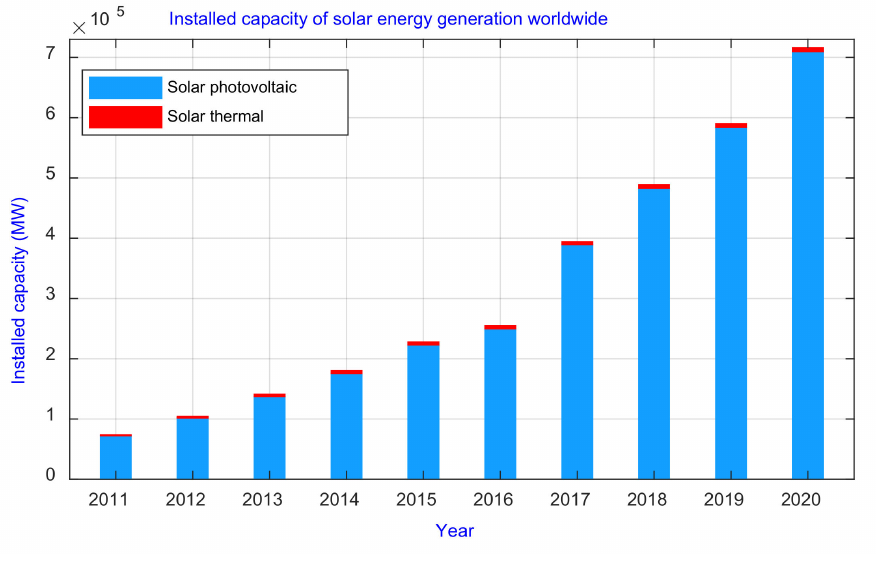
Figure 1. Growth trend of PV energy